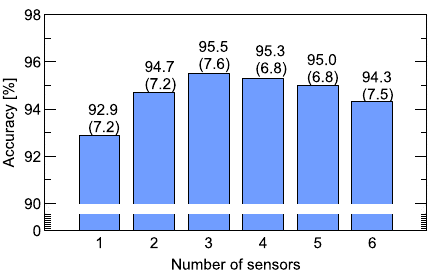
Figure 4. Accuracy of odor classification for various numbers of sensors from which data are used for model training. All training variables for these sensors listed in Appendix A are used. Above the bars, the average model accuracy and standard deviation (in brackets) are